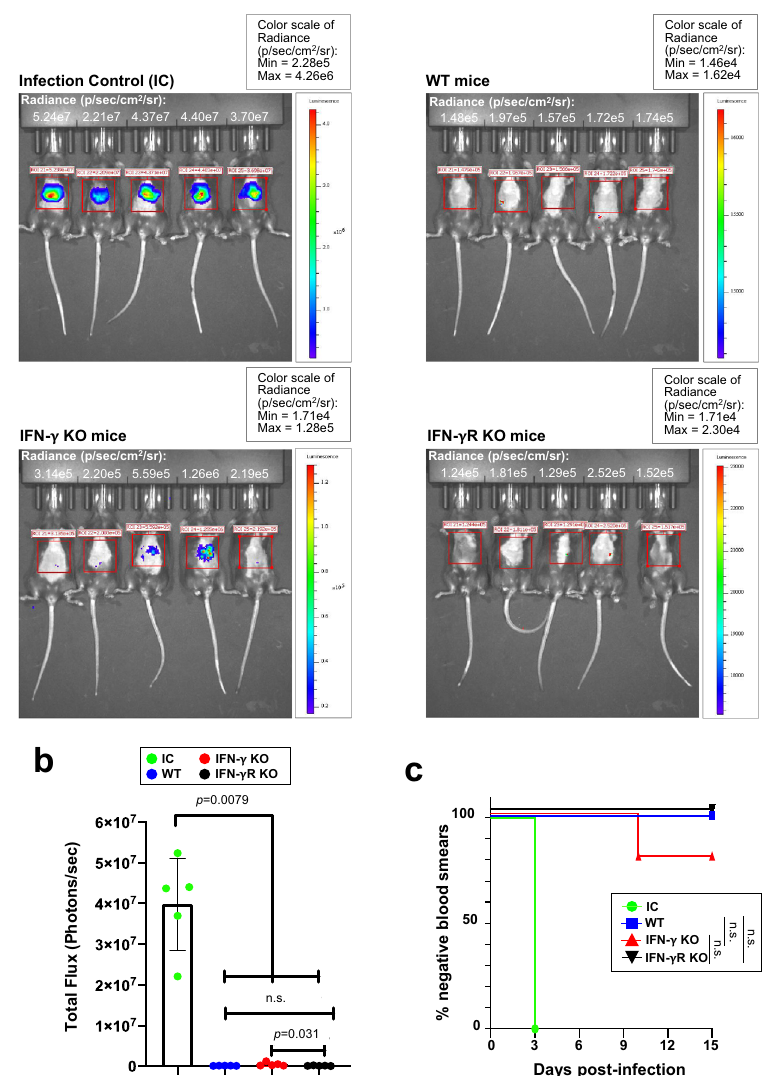
Fig. 7 IFN- γ is not required for protection rendered by PbATG8-OE-CVac. a , b Bioluminescence imaging of mice infected with Pb-GFP-Luc parasites to assess parasite burden in the liver and quanti fi cation. Absolute luminescence was measured as photon/s in infection control mice and PbATG8-OE-CVac-immunized animals: WT mice, IFN- γ -KO mice, or IFN- γ R-KO mice. Data representative of one experiment done twice with fi ve mice in each group, are means ± SD (values in photons/s were 169,520 ± 18,723 for WT mice; 509,460 ± 440,595 for IFN- γ -KO mice; 167,660 ± 52,218 for IFN- γ R-KO mice). Signi fi cance was determined by Mann – Whitney test. c Kaplan – Meier survival plot showing days to blood-stage infection. WT: C57Bl/6J mice immunized with PbATG8-OE-CVac. n.s. p > 0.05, measured by log-rank Mantel – Cox